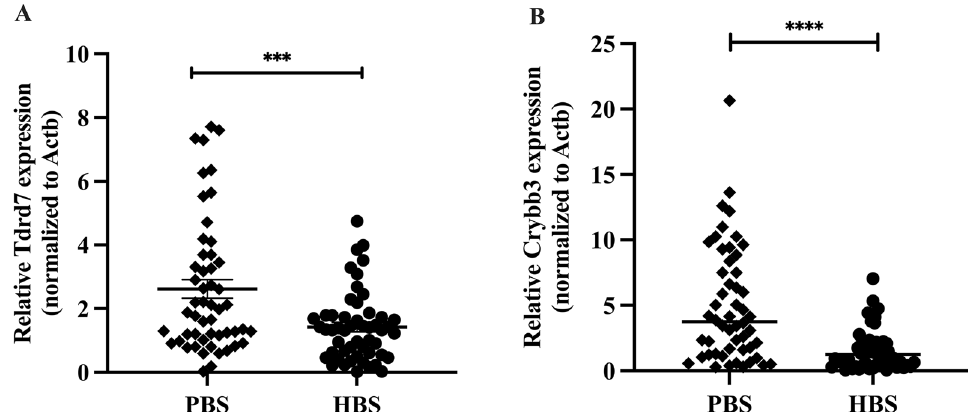
Fig. 4 Expression levels of TDRD7 and CRYBB3 in peripheral blood samples in comparison to those in healthy blood samples. *** P < 0.001, **** P < 0.0001. PBS Peripheral Blood Samples, HBS Healthy Blood Samples